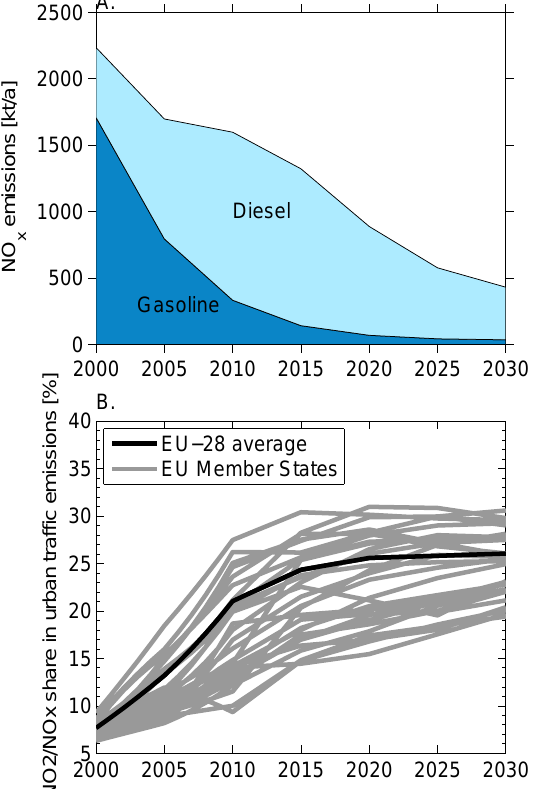
Fig. 10. (A) Trends in NO x emissions from passenger cars in the EU-28 under the current legislation scenario. (B) Share of primary NO 2 in NO x emissions from road traffic, in the individual EU Mem- ber States (grey) and the EU-28 mean (black).